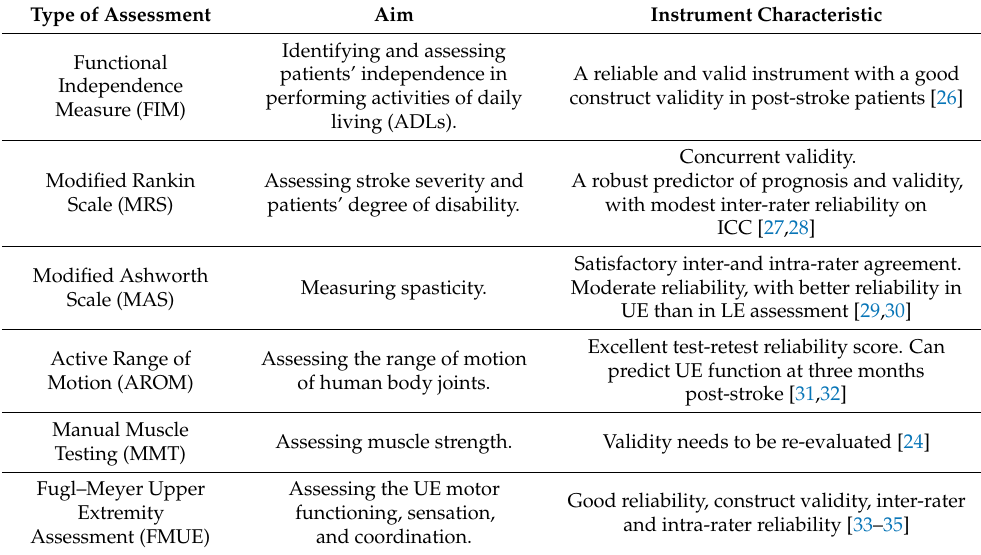
Table 3. Outcome measures for UE assessments in post-stroke